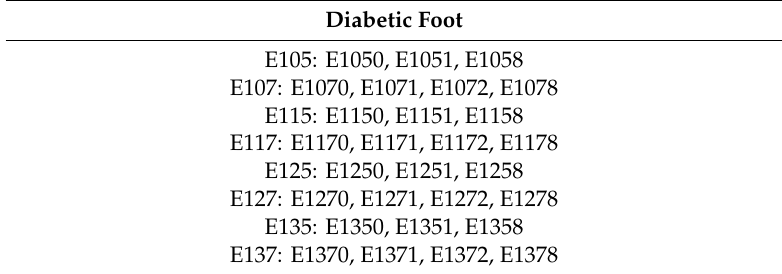
Table 1. Diabetic foot ulcer (DFU) and peripheral arterial disease (PAD) codes and behavior codes included in this